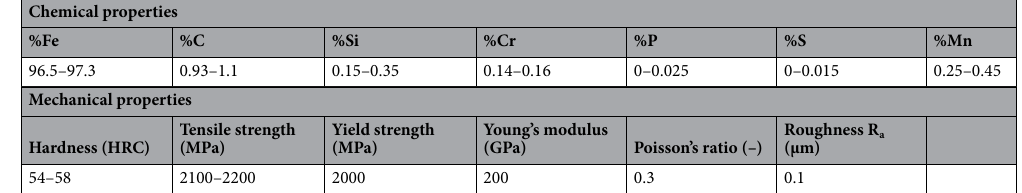
Table 4. Chemical and mechanical properties of ball material.